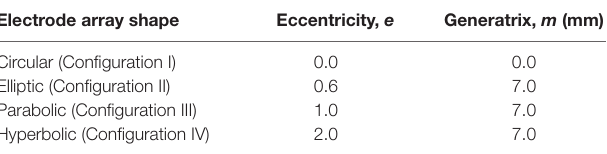
TaBle 1 | Geometrical characteristic for each electrodes configuration.